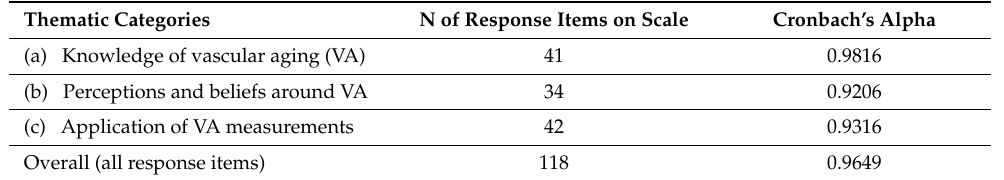
Table 3. Reliability coefficient (Cronbach’s alpha) for the final